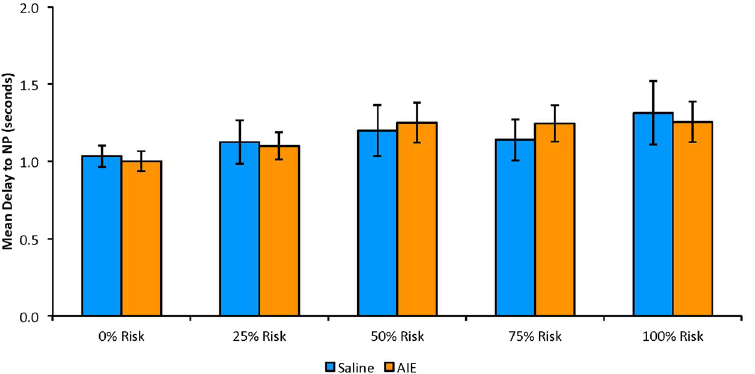
Figure 5. Mean ( ± SEM) delay to initial nosepoke (NP) in choice trials at each risk level, averaged across all days of testing (days 1–20). Maximum potential delay to nosepoke is 10 s. No difference found between treatment